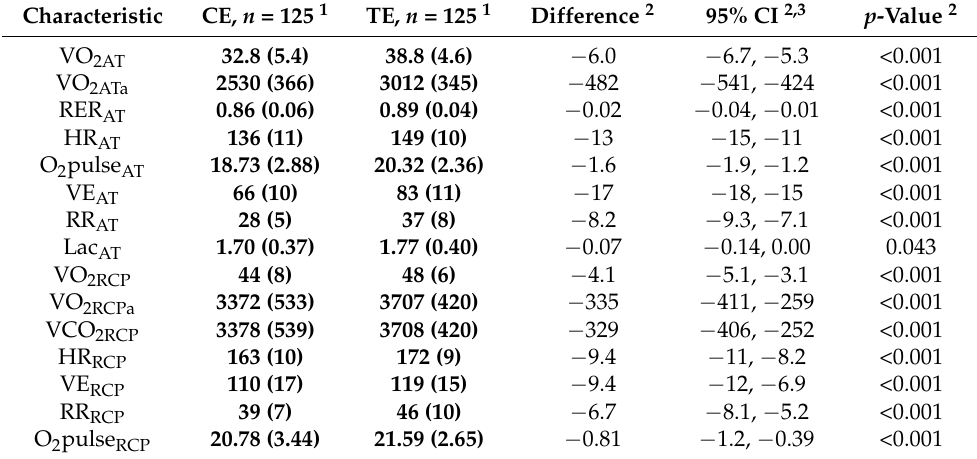
Table 4. Differences between cycle ergometry (CE) and treadmill (TE) CPET results in male partici- pants; significant results are